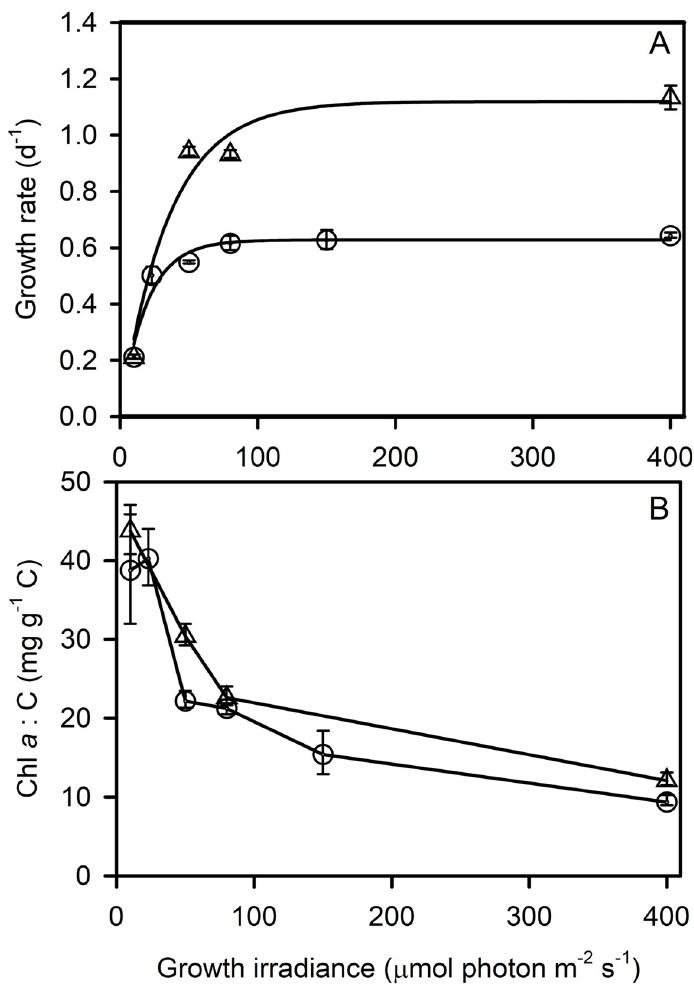
Fig 1. (A) Growth rate of C . neogracilis cultures versus growth irradiance at 0˚C (circles) and 5˚C (triangles). A Poisson function was fitted to the data and gives an estimate of μ max of 0.63 d -1 and a K E of 19 μ mol photon m -2 s -1 at 0˚C and a μ max of 1.1 d -1 and a K E of 35 μ mol photon m -2 s -1 at 5˚C. (B) Chl a : C ratio of C . neogracilis cells versus growth irradiance at 0˚C (circles) and 5˚C (triangles). In (A) each data point is the mean growth rate of 3 cultures measured each day over 10 consecutive days. In (B), each data point is the mean of 3 cultures measured each day over 3 consecutive days (23, 50, 80, 150, 400 μ mol photon m -2 s -1 ) or 2 days (10 μ mol photon m -2 s -1 ). Error bars represent standard